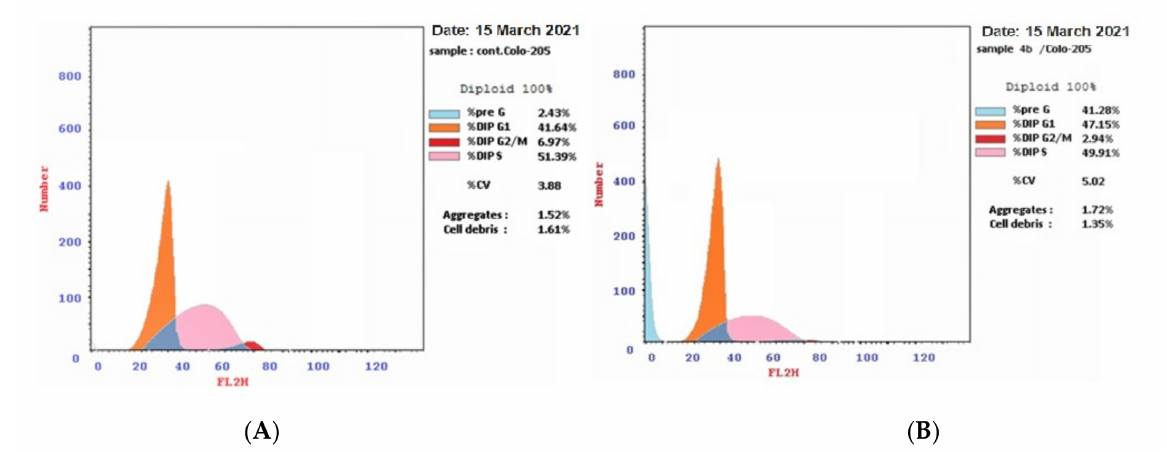
Figure 5. Effect of compound ( A ) 4b , and ( B ) DMSO as control on the percentage of accumulation of cells at different phases of cell cycle.